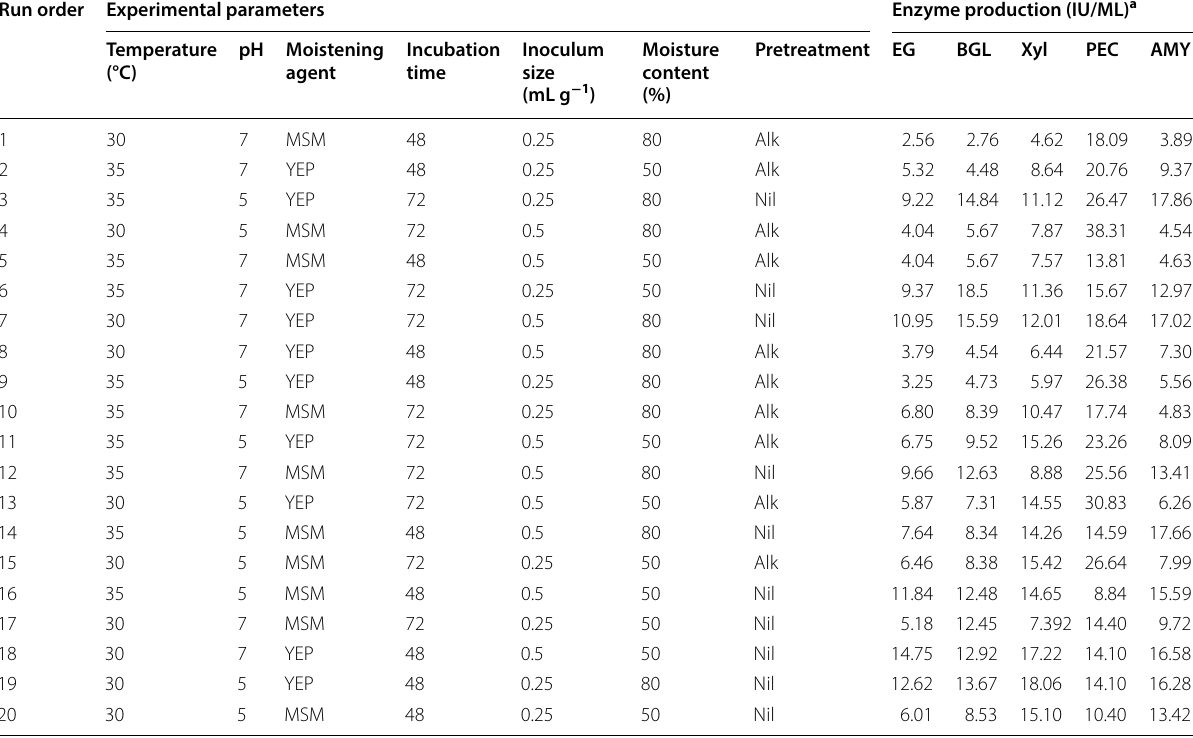
Table 3 Plackett–Burman for alkali-pretreated